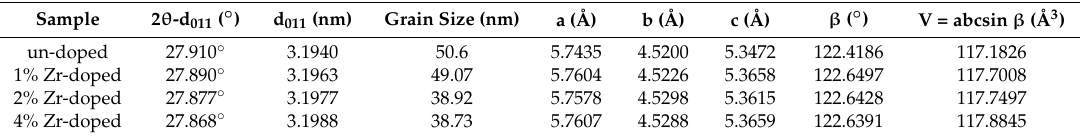
Table 1. Grain size, d 011 interplanar spacing, lattice parameters and volume of the unit cells of